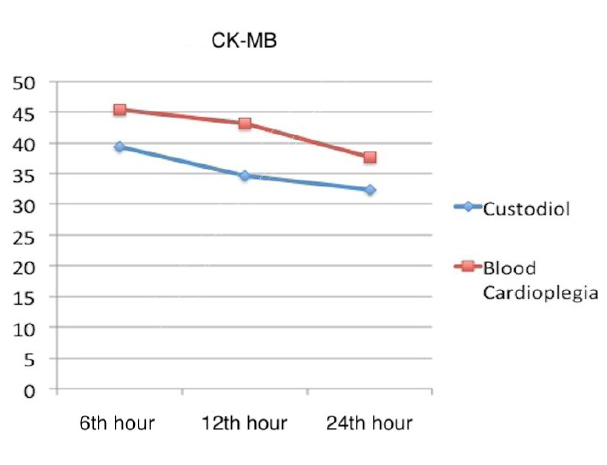
Fig. 2 - Mean CK-MB values for both Custodiol and blood cardioplegia groups in 6 th , 12 th and 24 th hours after the cross-clamp was removed.was removed.